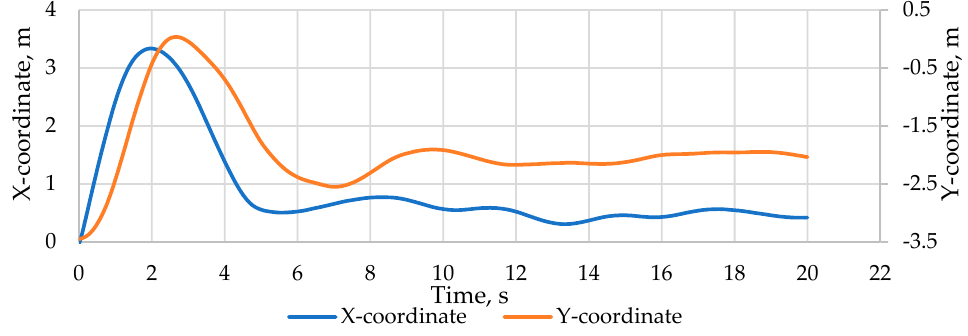
Figure 11. Average particle coordinates during simulation.